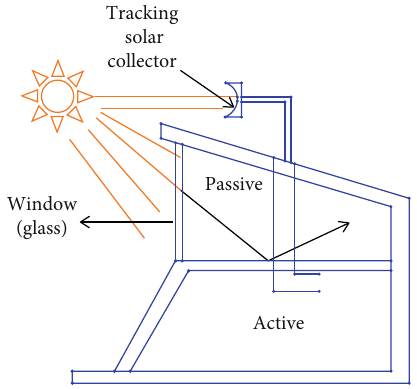
Figure 1: Active versus passive daylighting